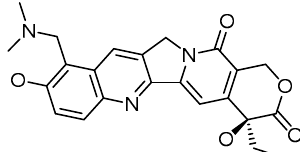
Figure 3. Chemical structure of topotecan.